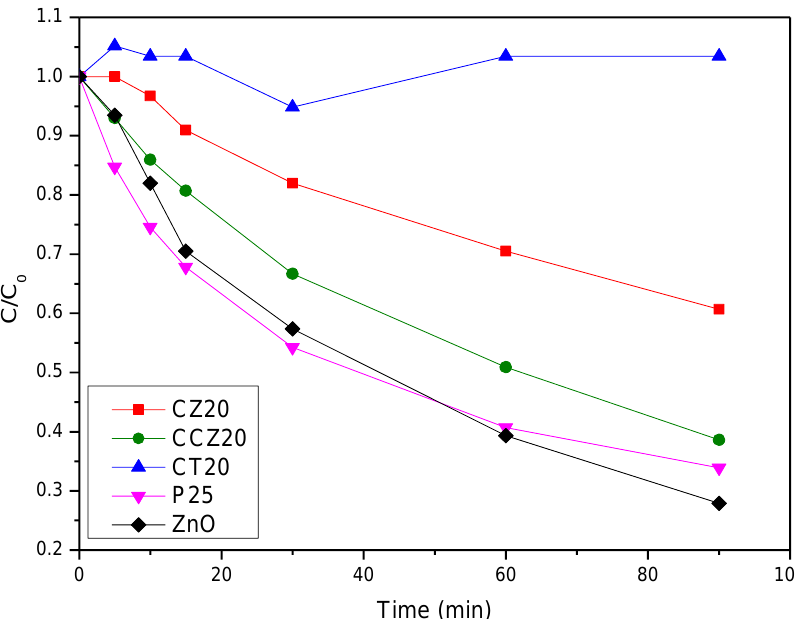
Figure 1. Time evolution of MB relative concentration C/C 0 during the photo-catalytic tests of the composite samples under UV light irradiation.